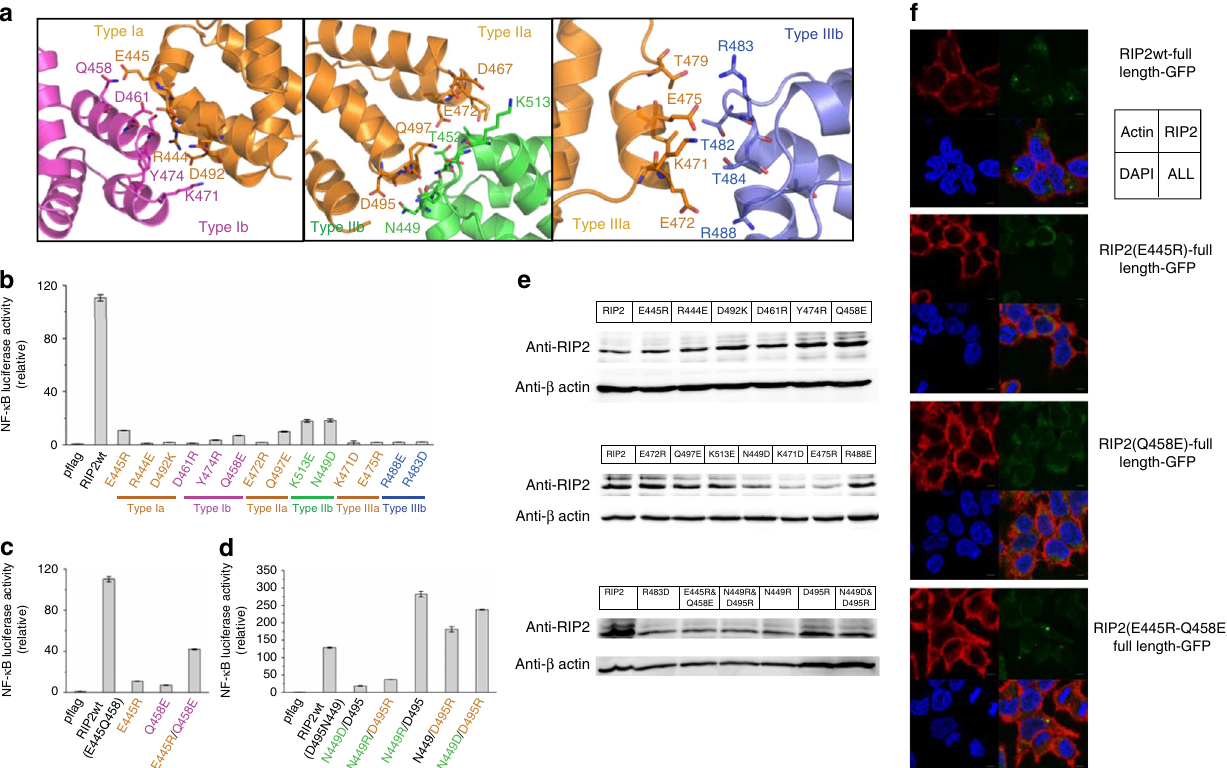
Fig. 6 Interdomain surface interactions within the RIP2 – CARD fi lament. a Cartoons illustrated the details of Ia:Ib, IIa:IIb, and IIIa:IIIb interactions in RIP2 – CARD fi lament. Residues at the interface are shown in stick models. b NF- κ B promoter activation by RIP2 and RIP2 single-point mutants. These RIP2 point mutations localized on the interaction interfaces and showed loss of function in terms of NF- κ B promoter activation. c NF- κ B promoter activation by RIP2, RIP2 single-point mutants E445R, R458E, and RIP2 double mutant E445R andR458E. The single mutants all showed loss of ability to activate NF- κ B promoter, while the E445R and R458E double mutant partially restored NF- κ B promoter activation. Error bar represents standard deviation values of three independent repeats. d NF- κ B promoter activation by RIP2 and RIP2 mutants in HEK293T cells. RIP2 single-point mutants N449D and RIP2 double mutant N449R andD495R showed loss of function. While RIP2 single-point mutants N449R, D495R, and double mutant N449D and D495R showed higher NF- κ B luciferase activities. Error bar represents standard deviation values of three independent repeats. e Expression levels of all RIP2 mutants are similar. HEK293T cells were transfected with wild-type RIP2 and RIP2 mutants. Cells were harvested 24 h post transfection. Levels of over-expressed wild-type RIP2 and RIP2 mutants were measured by anti-RIP2 antibody. Western blots were representative of three independent experiments. f Confocal microscope images of wild-type RIP2 – GFP, RIP2(E445R) – GFP, RIP2(R458E) – GFP, and the double mutant RIP2(E445R – R458E) – GFP. The charge-reversal double mutant regained the puncta formation activity. Gray scale bar: 5 μ Only their corresponding seeds induced their oligomerization, but not any other seed complexes, as shown in Supplementary Figure 4d.